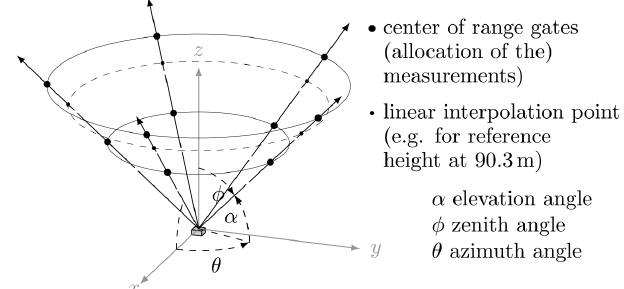
Figure 2. The DWL observation principle is shown here with five beams per cycle. Each beam consists of several thousand laser pulses, and the backscattered signal is affiliated with a discrete se- ries of range gates depending on the length of a single laser pulse and the traveling time. The resulting Doppler velocities are assigned to center-of-range gates. In order to obtain comparable results at in- termediate heights, a linear interpolation between the two neighbor- ing measurements along each beam is performed.